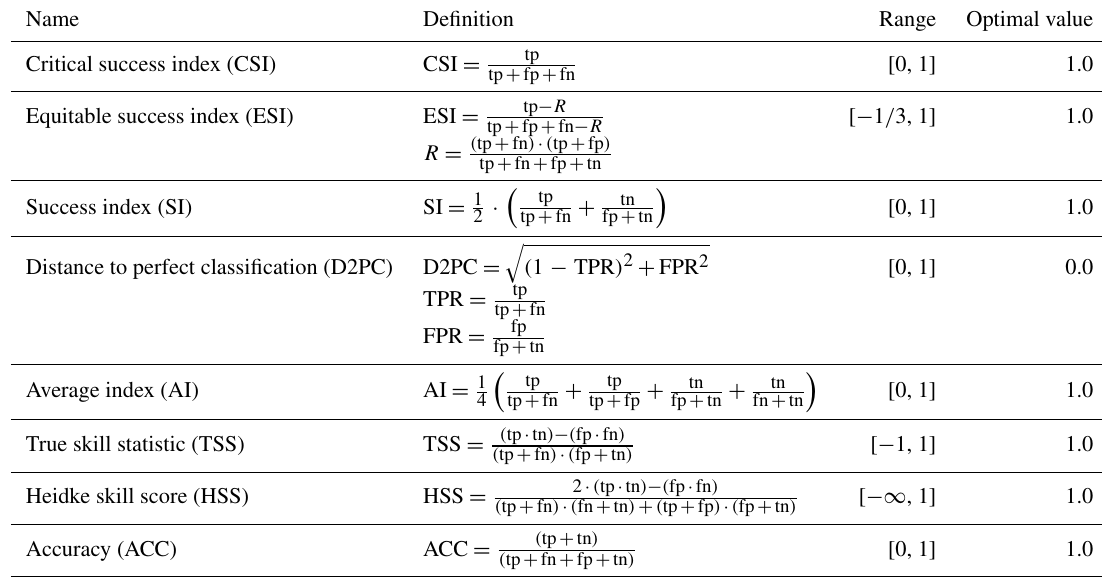
Table 1. Indices of goodness of fit for comparison between actual and predicted